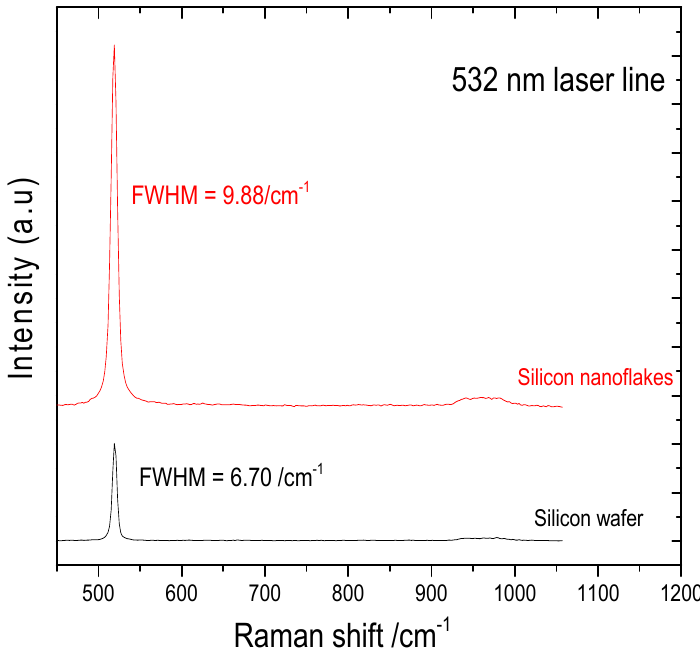
Figure 10. Raman spectra of silicon wafer and the as-etched silicon nanoflakes.